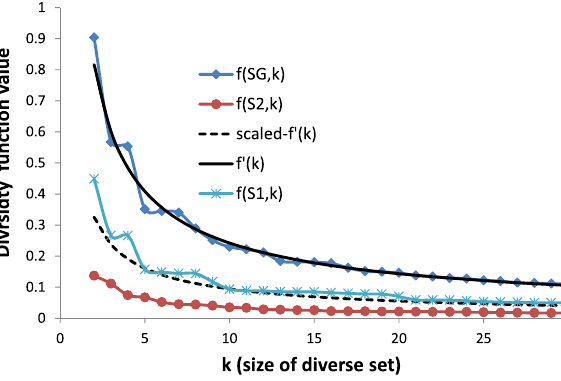
R ; c for current query result set X c generated from diverse overlapping results of